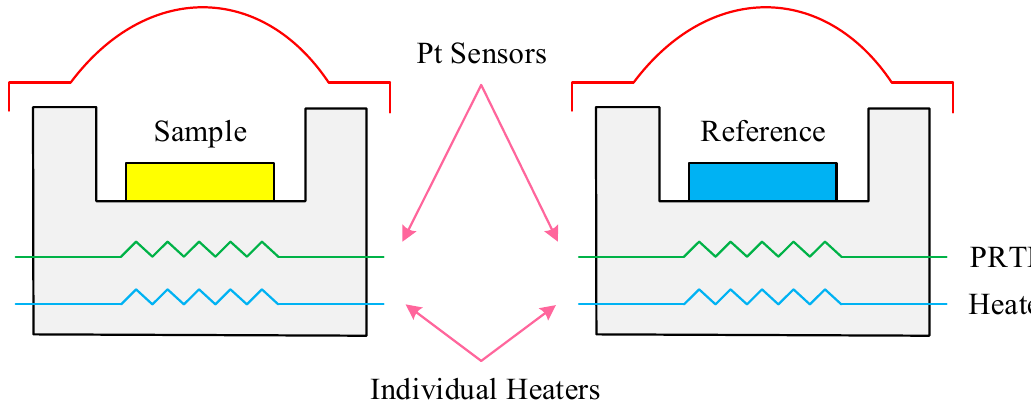
Figure 3. The schematic diagram of di ff erential scanning